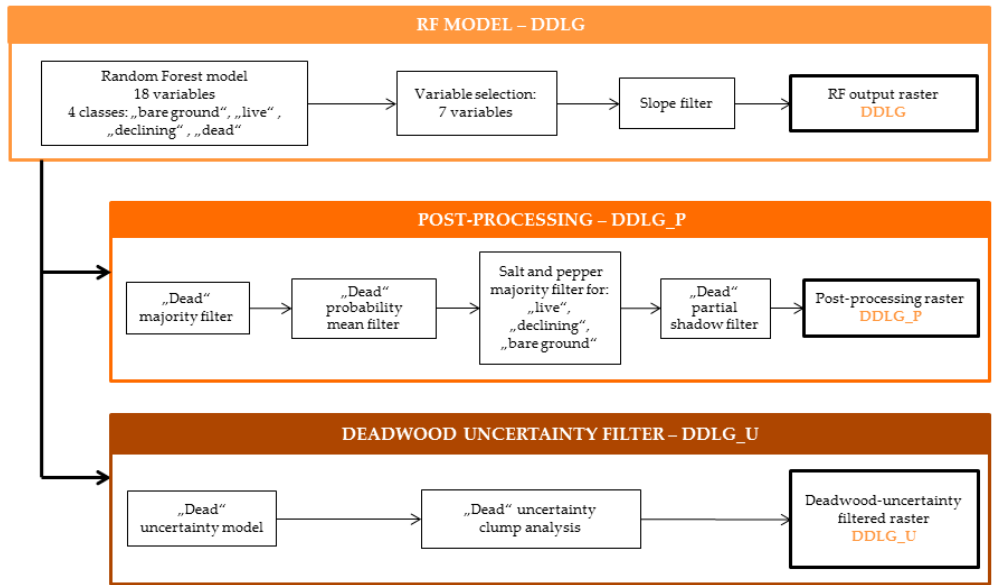
Figure 3. Methodological steps used for deadwood detection: First, a random forest model (DDLG) was calibrated, distinguishing between “dead”, “declining”, and “live” trees, as well as “bare ground”. The model results were enhanced using two alternative approaches for addressing the deadwood-bare ground misclassification issue: (1) a chain of post-processing steps (DDLG_P) and (2) with the generation of a model-based deadwood-uncertainty filter (DDLG_U). Bold frames represent the classification results. The acronyms for the analysis steps correspond with the model classes: dead (D), declining (D), live (L), bare ground (G), as well as indicated post-processing (P) and uncertainty filter (U). For methodological details of the single analysis steps see Sections 2.5.1-2.5.3.